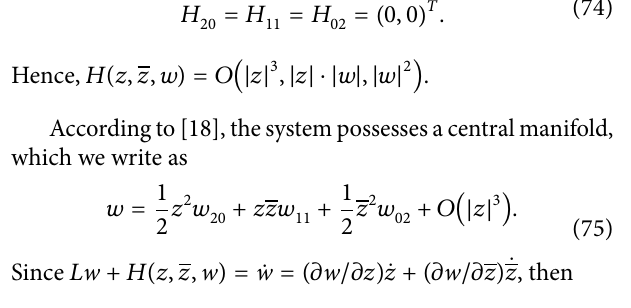
Figure 2: (a) The phase orbit starting from and (b) equilibrium is unstable and phase orbit starting from 𝜎 = 0.5, 𝜇 = 0.155 for 𝜎 = 0.5, 𝜇 = 0.14